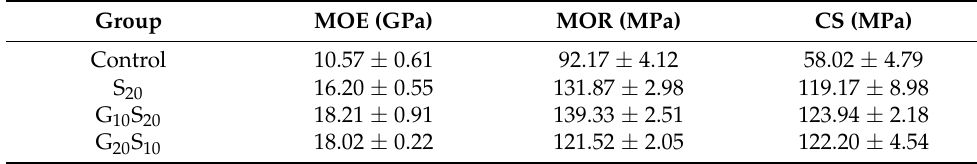
Table 3. Mechanical properties of the modified